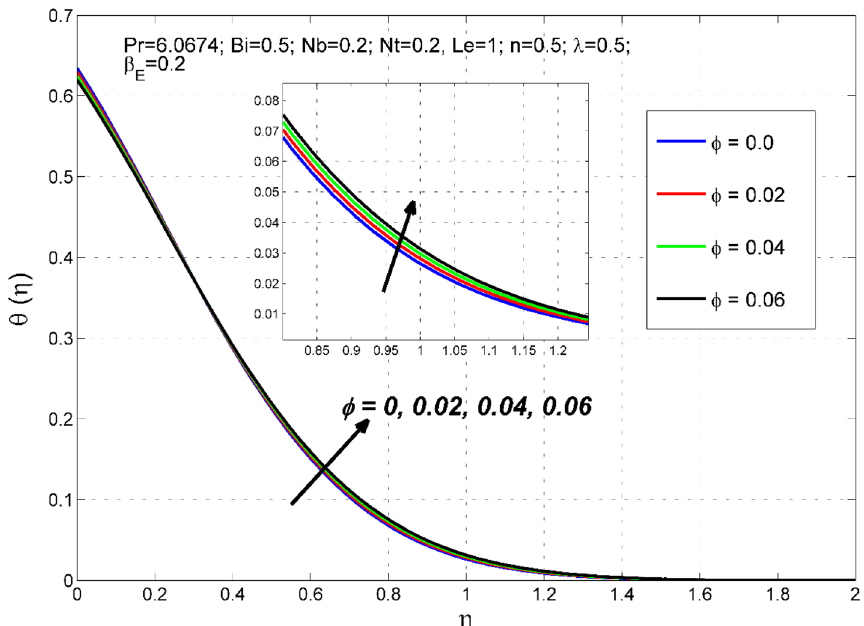
Figure 16. The temperature distribution θ (η) behavior for the variation of the nanoparticles volume fraction φ